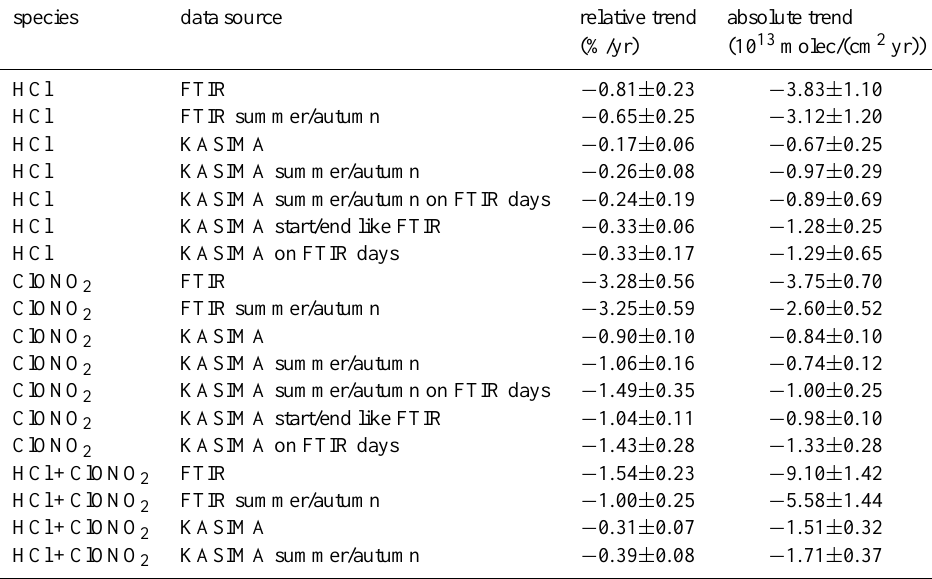
Table 2. Absolute and relative trends for HCl and ClONO 2 column abundances from the FTIR measurements and KASIMA model calcula- tions for Kiruna. The time range considered is 1996–2009. The “summer/autumn” time series contain the data between June and November